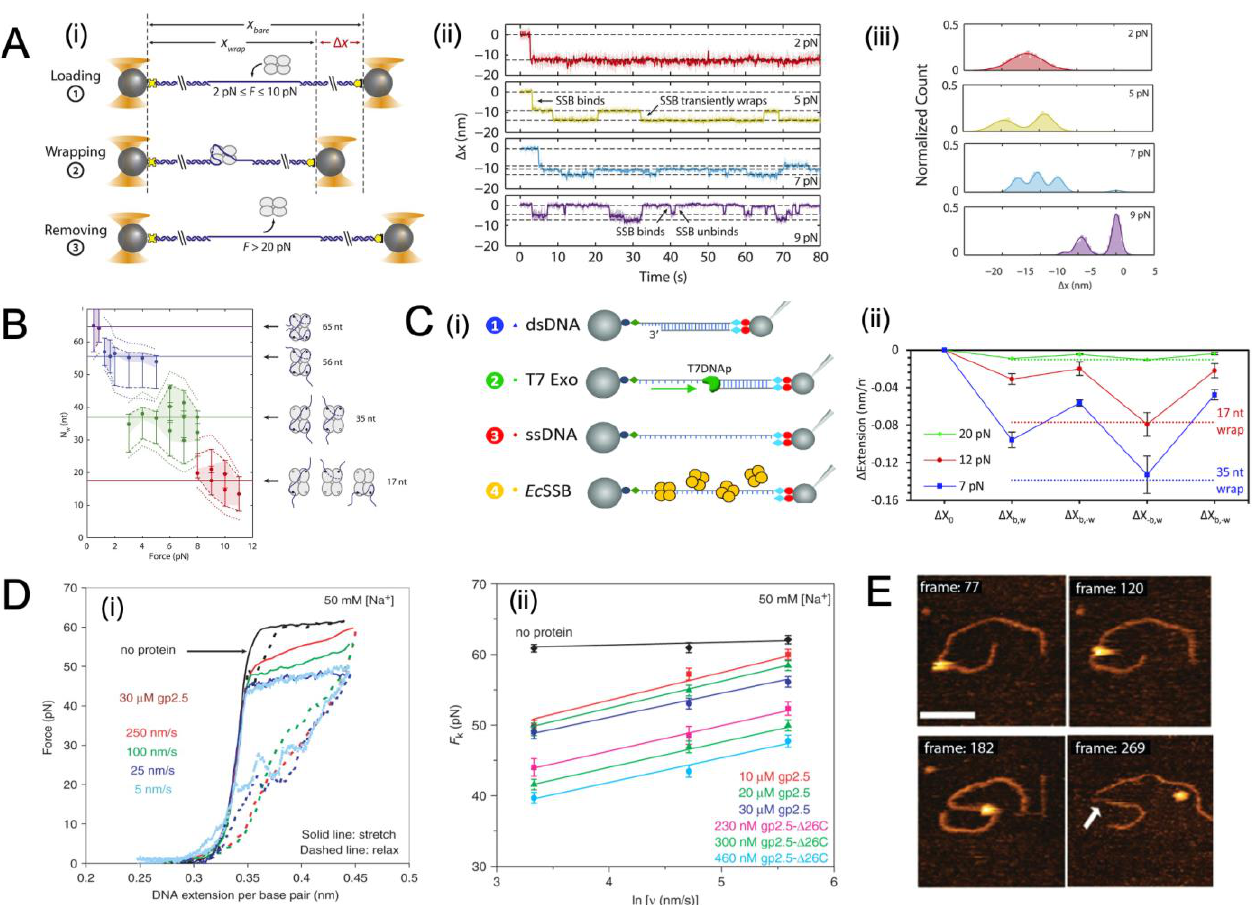
Figure 3. SSB interacting with ssDNA probed by single-molecule force spectroscopy. ( A ) Investi- gation of the intermediate states of ssDNA wrappers during SSB by single-molecule force spec- troscopy. (i) Schematic depiction of the SSB wrapping experiment under constant force. Between two optical traps, a DNA construct is held under a constant tension between 2 and 10 pN in the presence of proteins. The extension change is measured as a function of the SSB binding, wrapping, or unwrapping ssDNA. Following each observation, the SSB is removed by stretching the DNA construct to a high force (>20 pN). (ii) Representative time traces of SSB–ssDNA wrapping under 2, 5, 7, and 9 pN (with red, green, blue, and purple, respectively). The extension change data were collected at 66 kHz and averaged via a boxcar to 10 Hz (dark colour). All traces show SSB binding and compacting ssDNA as indicated by an extension decrease. With varying tensions, SSB exhibits a variety of intermediate wrapping states. The black dashed lines are indicative of the mean ex-tension change in each wrapping state. (iii) Distribution of extension changes for many SSB wrapping traces kept at constant tensions between 2 and 10 pN. This colour map corresponds to that in (ii). Solid lines represent multi-Gaussian fits to the distributions. Images adapted from Figure 2 of [16] under an Attribution 4.0 International (CC BY 4.0) License. ( B ) Plot of the number of wrapped nucleotides Nw as a function of various template tension F. The points are the best es-timates of Nw; dashed lines represent a tighter range of possible Nw values for each group of points derived from the SSB–ssDNA structure. Cartoon schematics depict possible wrapping modes cor-responding to the four groups. Rather than unwrapping gradually, ssDNA unwraps discretely under tension [32]. Images adapted from Figure 3 of [16] under an Attribution 4.0 International (CC BY 4.0) License. ( C ) The effect of tension on E. coli SSB–ssDNA binding dynamics. (i) Experimental method of determining E. coli SSB–ssDNA binding dynamics. A DNA construct of 8.1 kbp length is tethered between two functionalized beads (step 1, blue) with one bead held by a glass micropipette tip to extend the DNA, and the other bead held by a stationary optical trap to measures the template force. A long